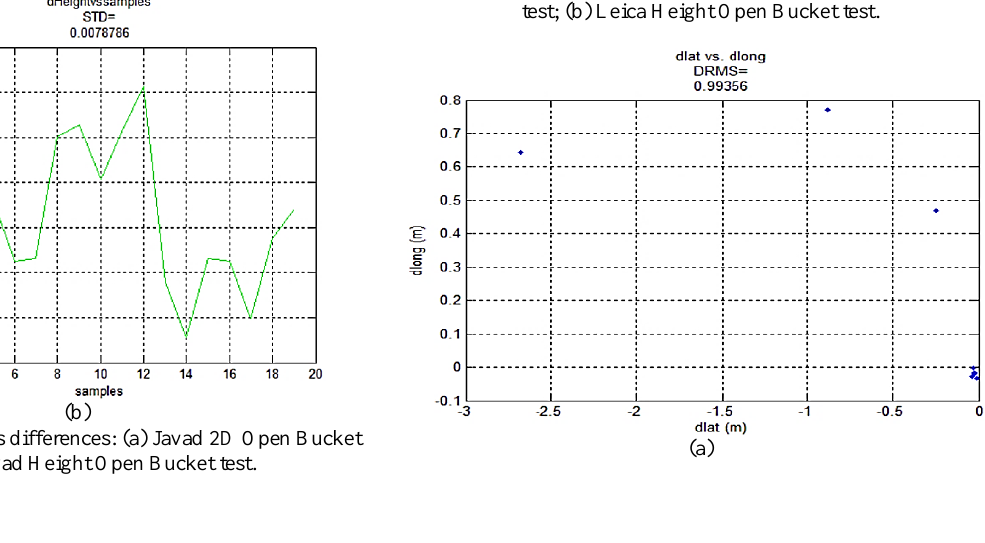
Figure 20. Coordinates differences: (a) Leica 2D Open Bucket test; (b) Leica Height Open Bucket